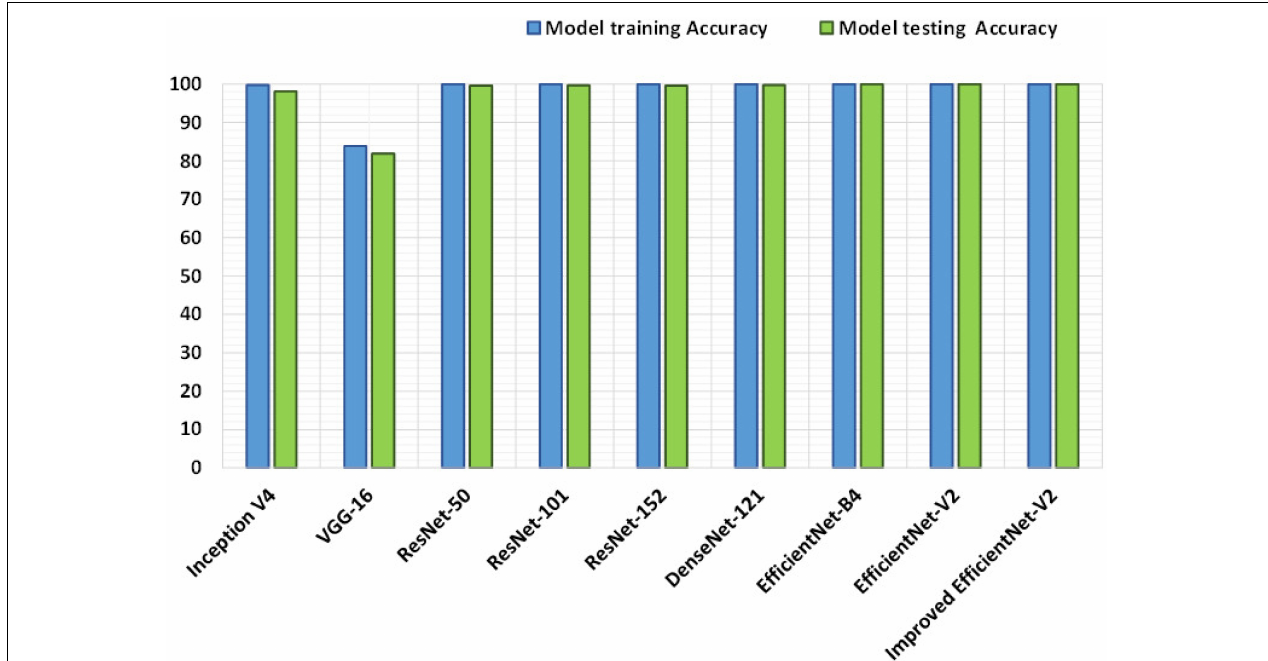
FIGURE 10 | Performance comparison of the presented approach with the base methods. TABLE 5 | Performance comparison of the presented framework with machine learning (ML)-based classifiers. Classifier Execution time (s) Total trainable model